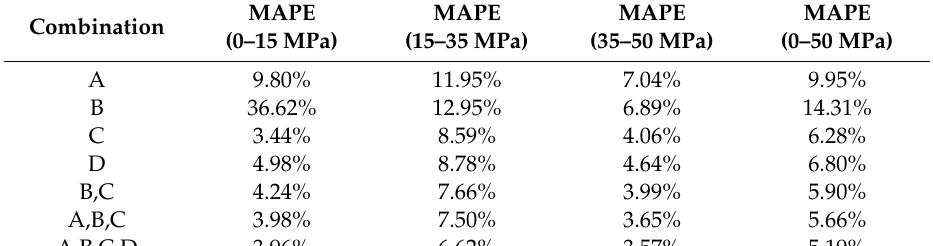
Table 12. MAPE values for each section of fc predicted using the ensemble method.